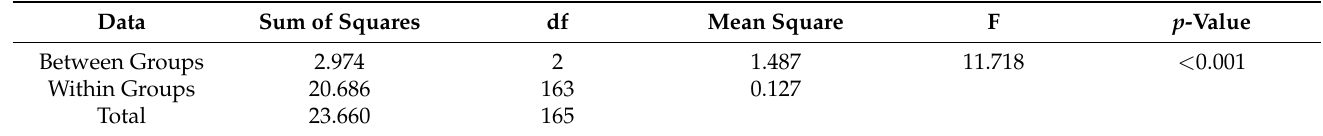
Table 12. Results for the ANOVA comparing the void volume fractions for the three plates.